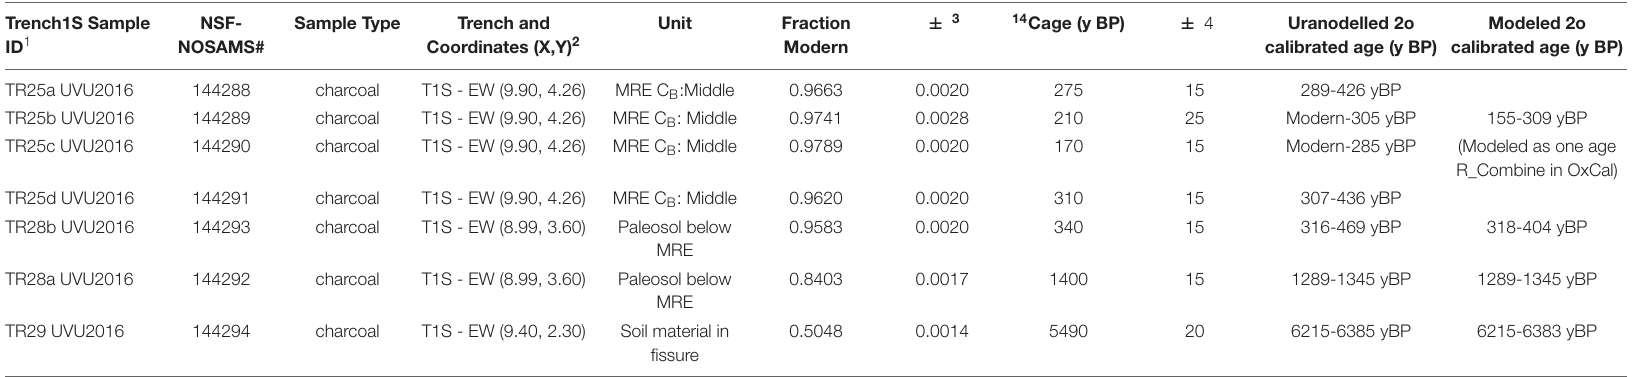
TABLE 2 | T1S radiocarbon data arranged by stratigraphic